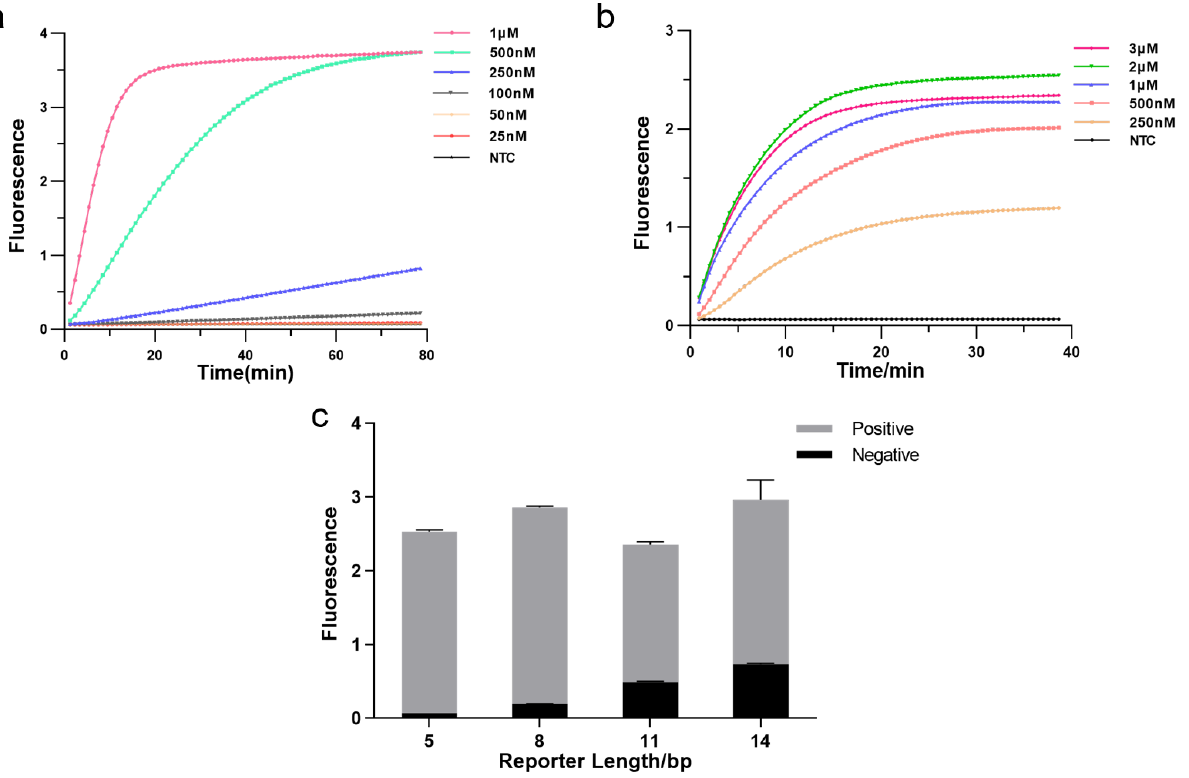
Figure 3. Optimizing the RPA-CRISPR reaction system. ( a ) Real-time fluorescence curves based RPA- CRISPR/Cas12a at different Cas12a protein concentrations. NTC: no template control. ( b ) Real-time fluorescence curves based RPA-CRISPR/Cas12a at different CrRNA concentrations. ( c ) Optimization of the FQ reporter length for the CRISPR detection. Various lengths (5, 8, 11, 14 bp) of FQ ssDNA reporter were tested to avoid false-positive results ( n = 3, error bars showed mean with